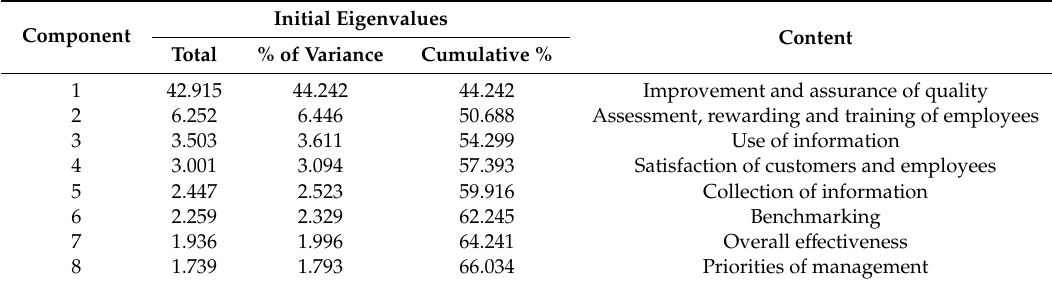
Table 11. Total variance